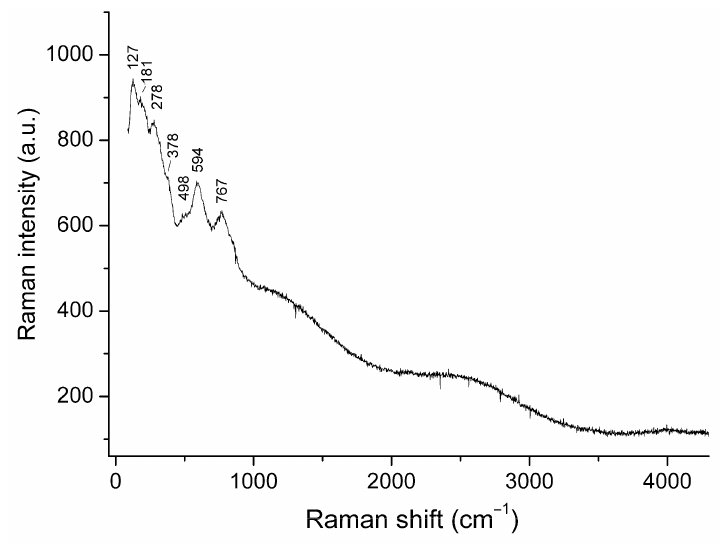
Figure 2. Raman spectrum of nöggerathite-(Ce) (a.u. = arbitrary units).